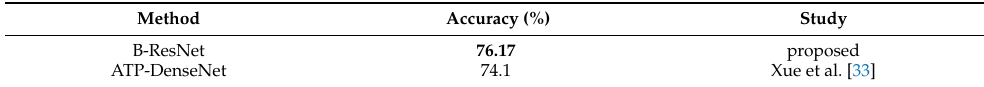
Table 2. Gender prediction accuracy on the KHATT